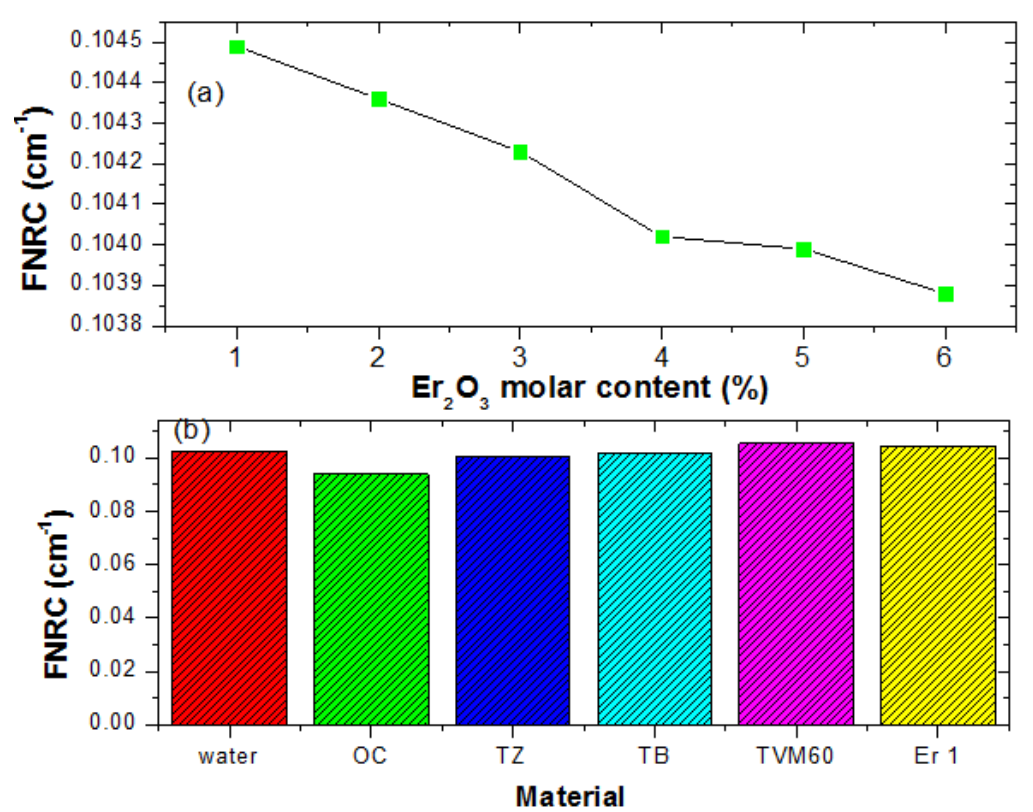
Figure 11. Influence of Er 2 O 3 molar concentration on the FNRC of the glasses ( a ) and FNRC of Er1 compared to other materials ( b ).